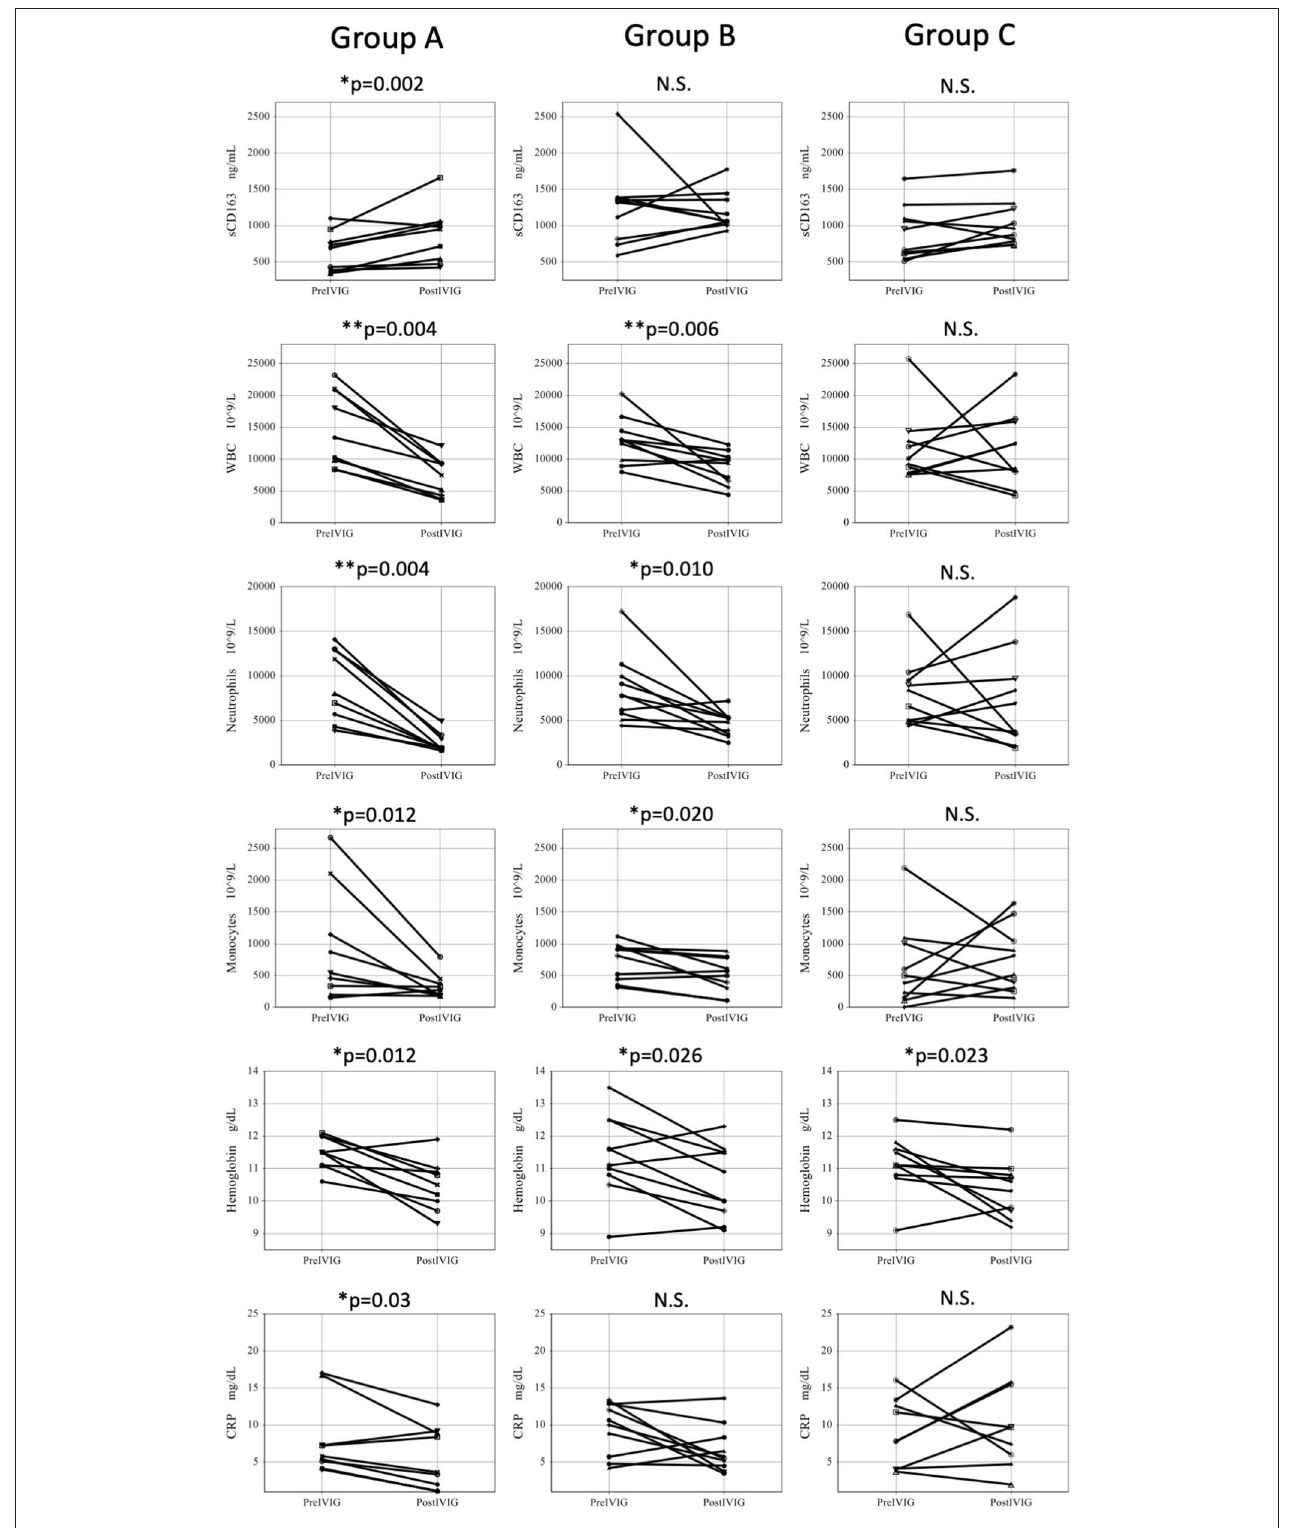
FIGURE 3 | Comparison of parameters before and after initial IVIG among three groups. Pre IVIG, before initial Intravenous immunoglobulin; Post IVIG, after initial intravenous immunoglobulin; Group A, initial IVIG responders; Group B, additional IVIG responders; Group C, patients who require 3rd line therapy; WBC, white blood cell; N.S., not significant, * P < 0.05, ** P <